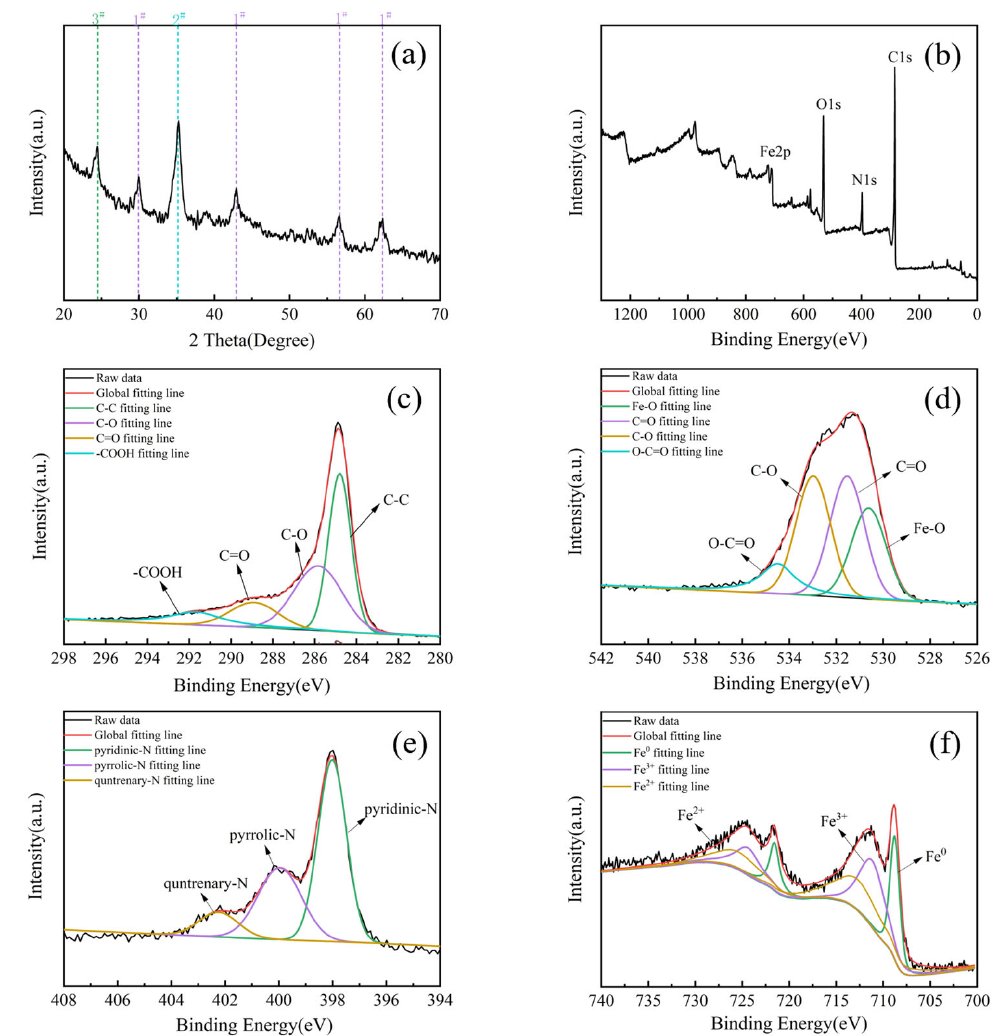
Figure 4. ( a ) XRD pa tt erns of the BAC (1#-Fe 3 O 4 , 2#-Fe 2 O 3 , 3#-Fe 3 C); ( b ) XPS survey spectrum of the BAC; ( c ) C1s, ( d ) O1s, ( e ) N1s, and ( f ) Fe 2p. BAC; ( c ) C1s, ( d ) O1s, ( e ) N1s, and ( f ) Fe